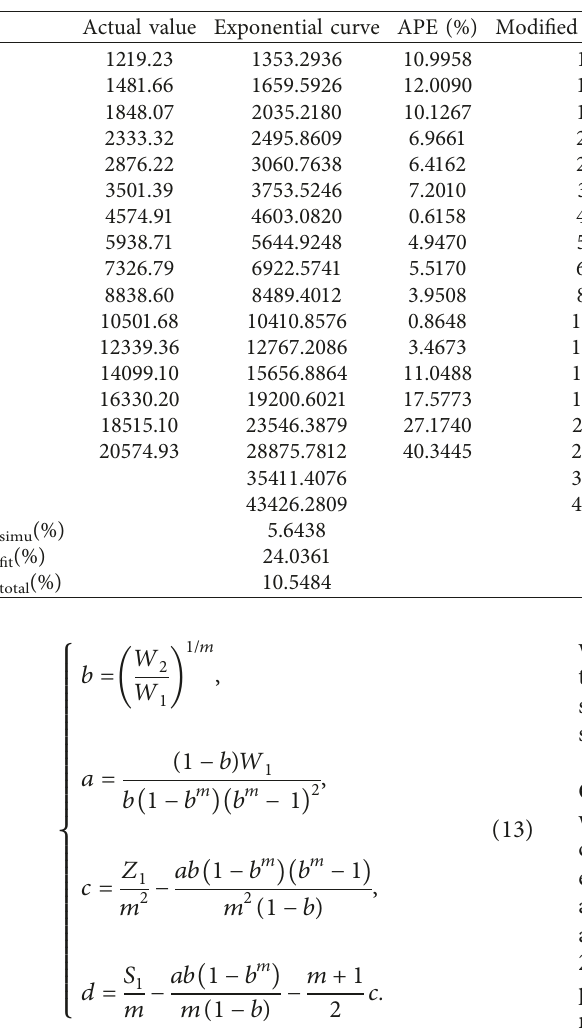
Table 1: Calculation results of private car ownership data by exponential curve, modified exponential curve, and the new exponential curve of first order polynomial